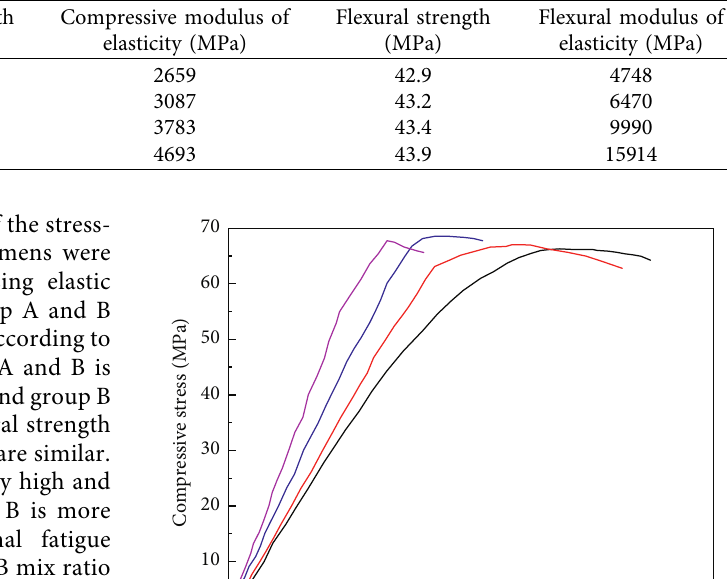
Table 5: Test values of compressive and flexural strength for PUC.